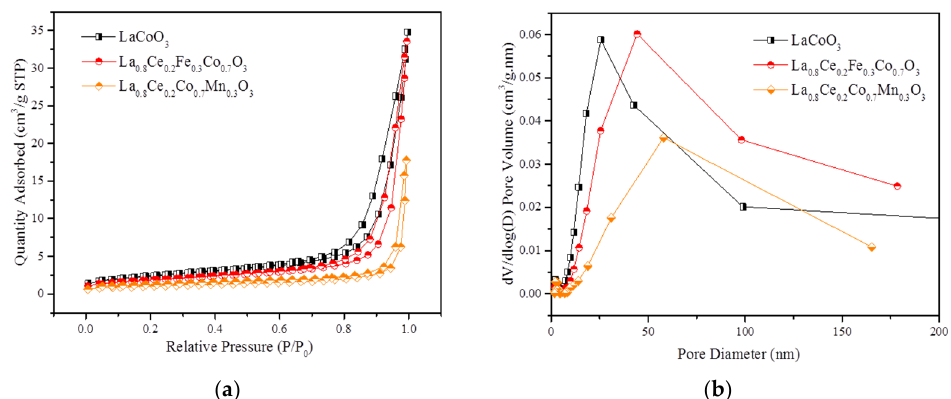
Figure 17. N 2 adsorption isotherms and PSD curves of catalyst samples: ( a ) N 2 adsorption isotherms; and ( b ) PSD curves.